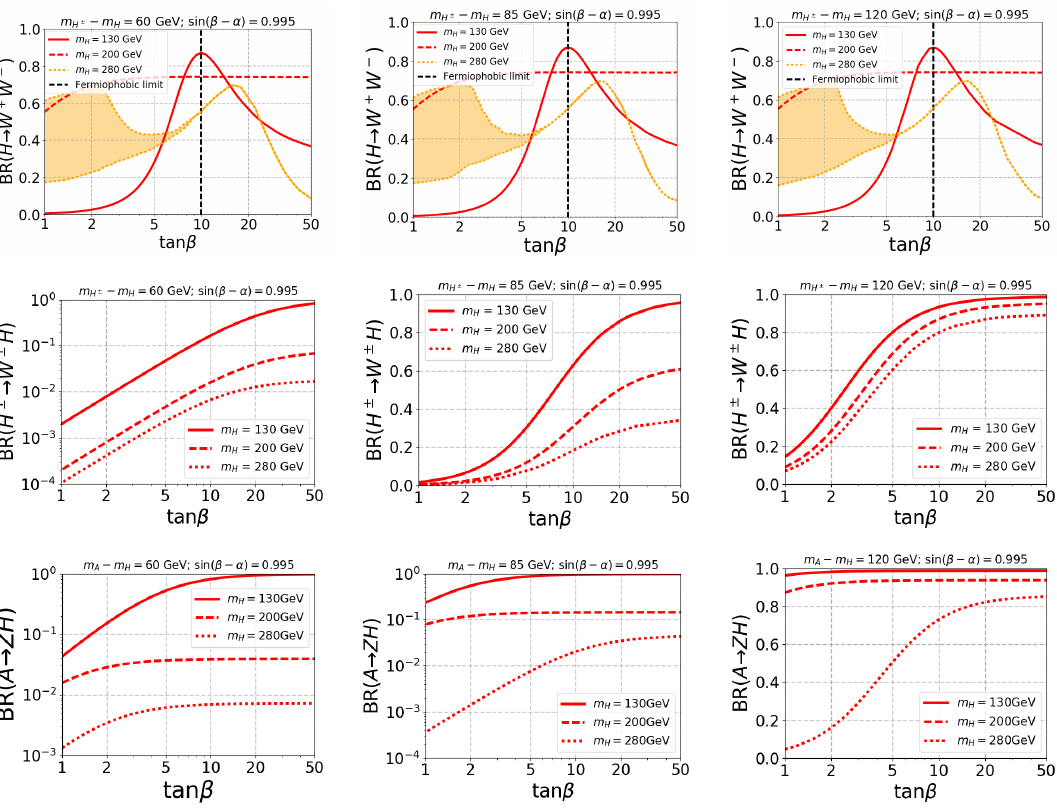
Figure 2 . Relevant branching ratio of the additional Higgs bosons decaying to gauge boson are shown for three different mass gaps. See text for the